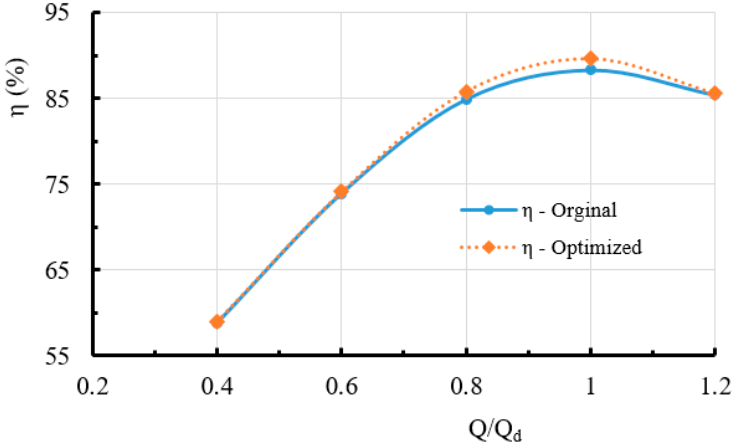
Figure 17. Predicted efficiency comparison at different flow rates.